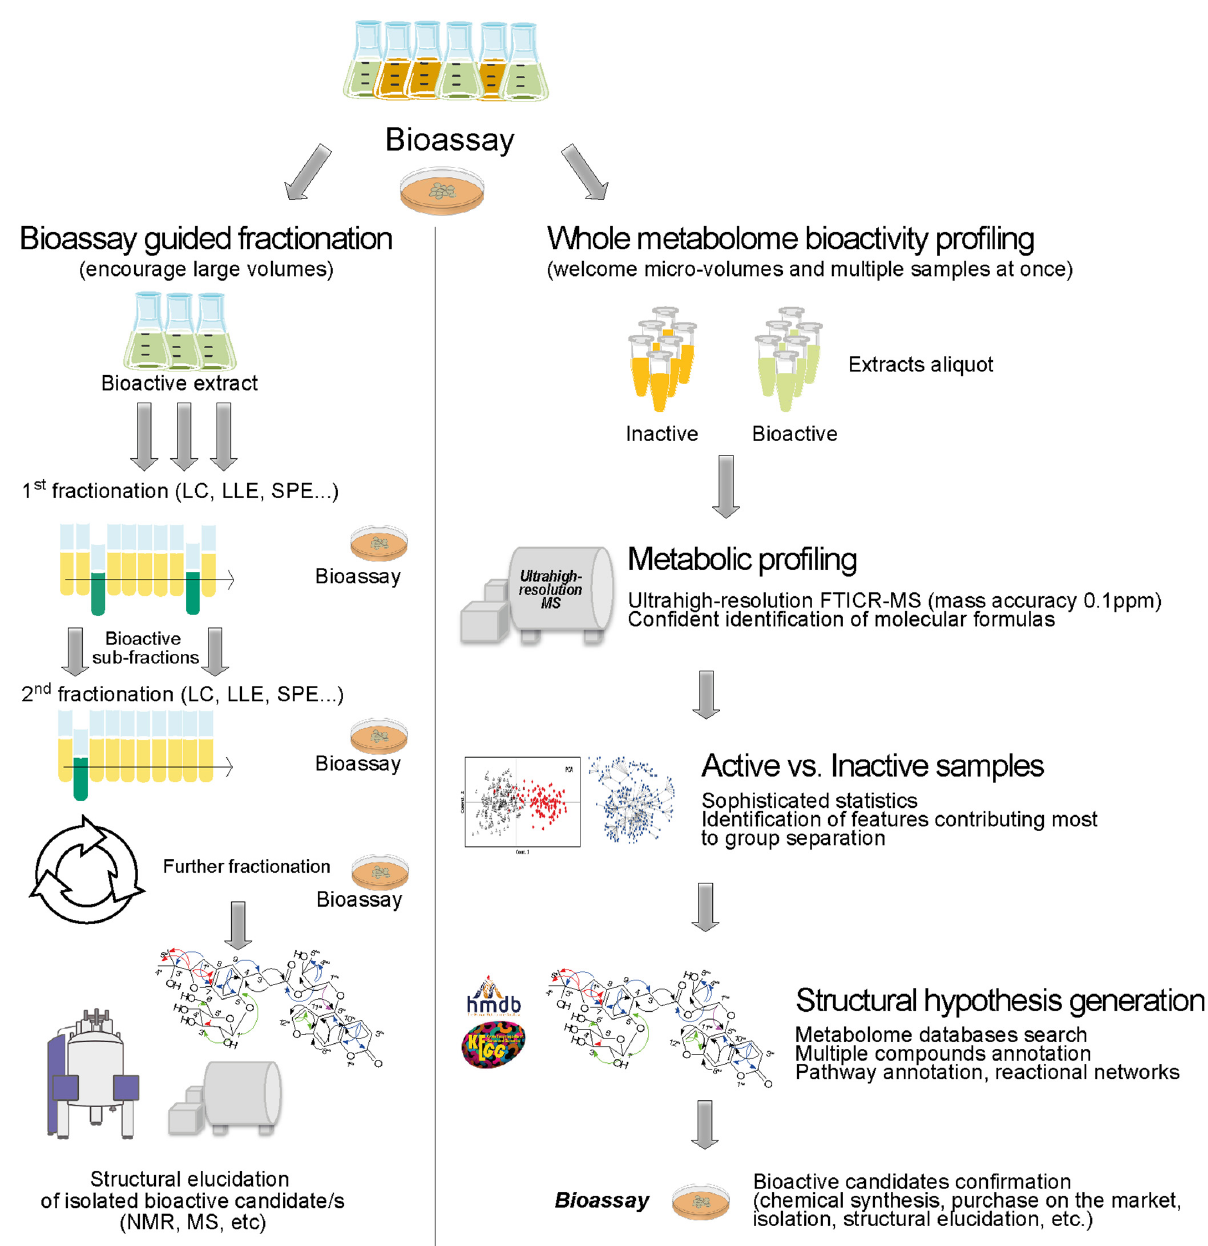
Figure 1. Schematic representation of two approaches to new bioactive compound discovery. (Left panel) Traditional bioassay-guided fractionation is time and labor intensive due to its step-by-step separation using chromatographic techniques followed by biological activity assessments. It re- moves most of the interfering matrix compounds but may lead to losses of active compounds. (Right panel) Holistic metabolomics approach deals with complexity, requires high level of expertise in instrumentation and data analysis, but offers scientists a broader picture of the biological system in study [19]. in study